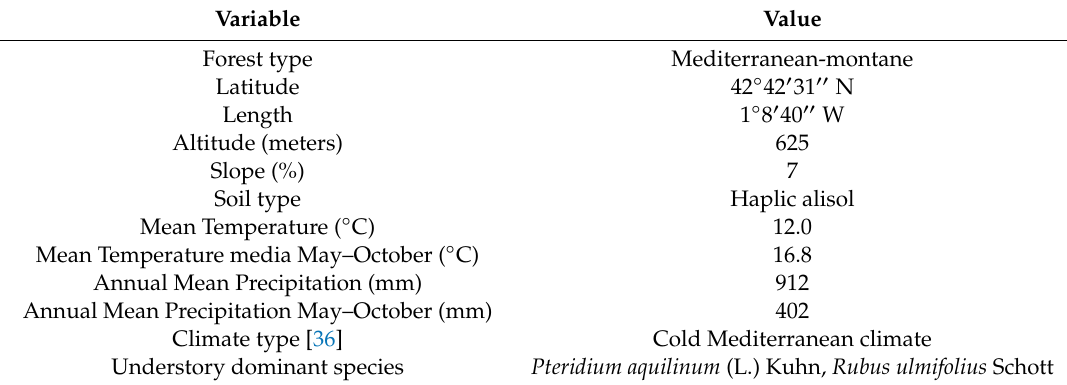
Table 1. Characteristics of the study area common to both canopy types